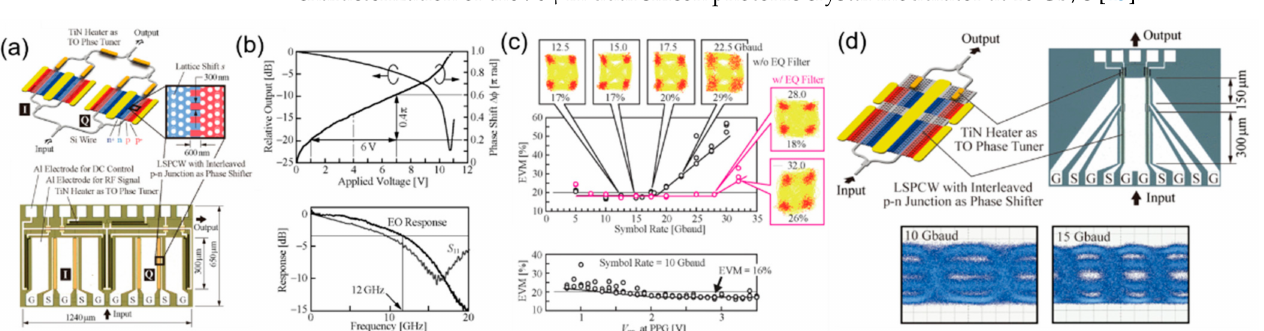
Figure 5. Sub − 100 µ m silicon photonic crystal modulator. ( a ) Schematic of the silicon photonic crystal modulators with dual and single modulation arm [44]. ( b ) Optical and SEM images of the 90 µ m dual phase-shifter modulator [44]. ( c ) Spectral characteristics of the 90 µ m dual silicon photonic crystal modulator [45]. ( d ) Eye diagram (10 Gb/s) of the 50 µ m dual silicon photonic crystal modulator [44]. ( e ) Eye diagram (40 Gb/s) of the 90 µ m single silicon photonic crystal modulator [44]. ( f ) Temperature characterization of the 90 µ m dual silicon photonic crystal modulator at 10 Gb/s [45].